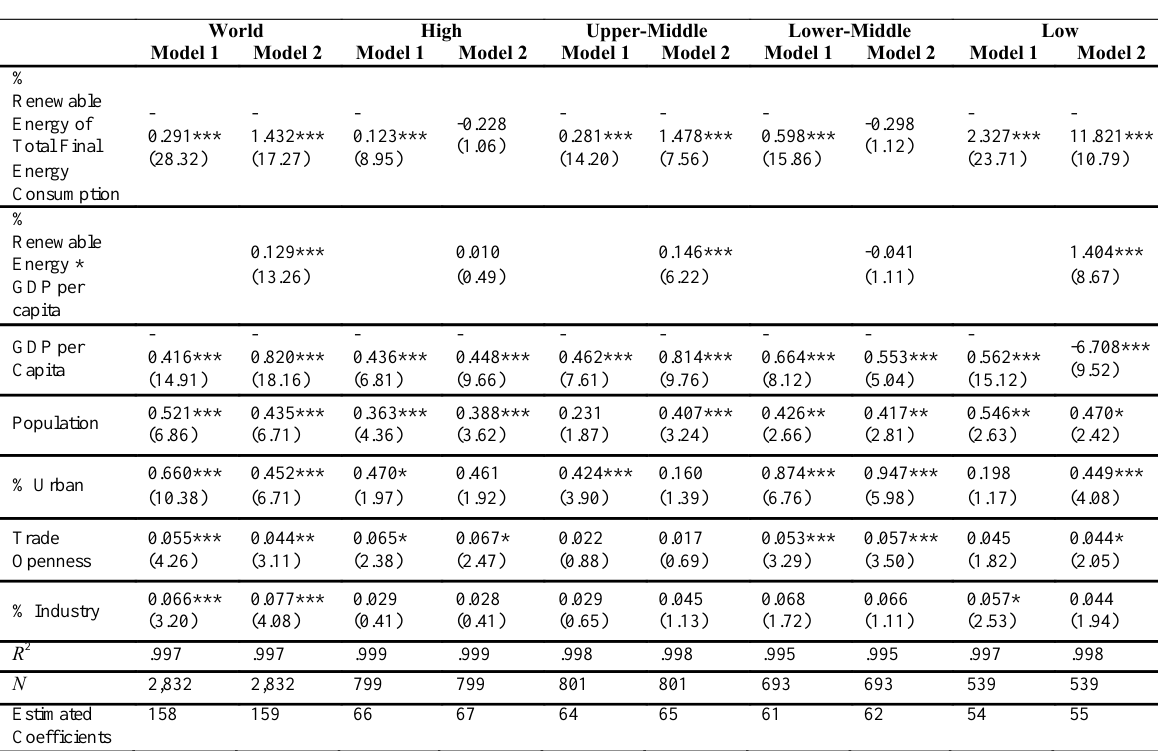
Table 5. Unstandardized Coefficients for the Regression of Carbon Dioxide Emissions per unit of GDP, 1990-2013: PW Regression Model Estimates with PCSE and an AR (1)